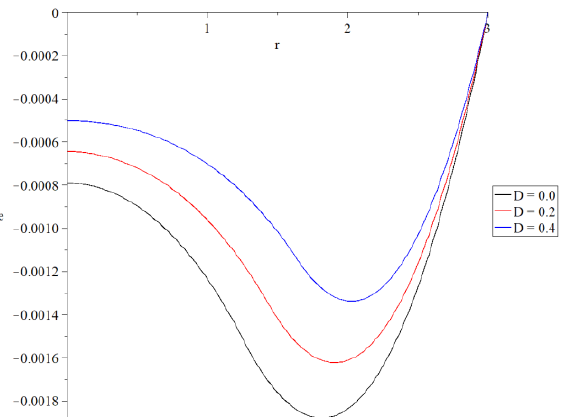
Figure 9. The distribution of the volumetric strain increment for the variance values of damage mechanics in the context of the hyperbolic two-temperature model.